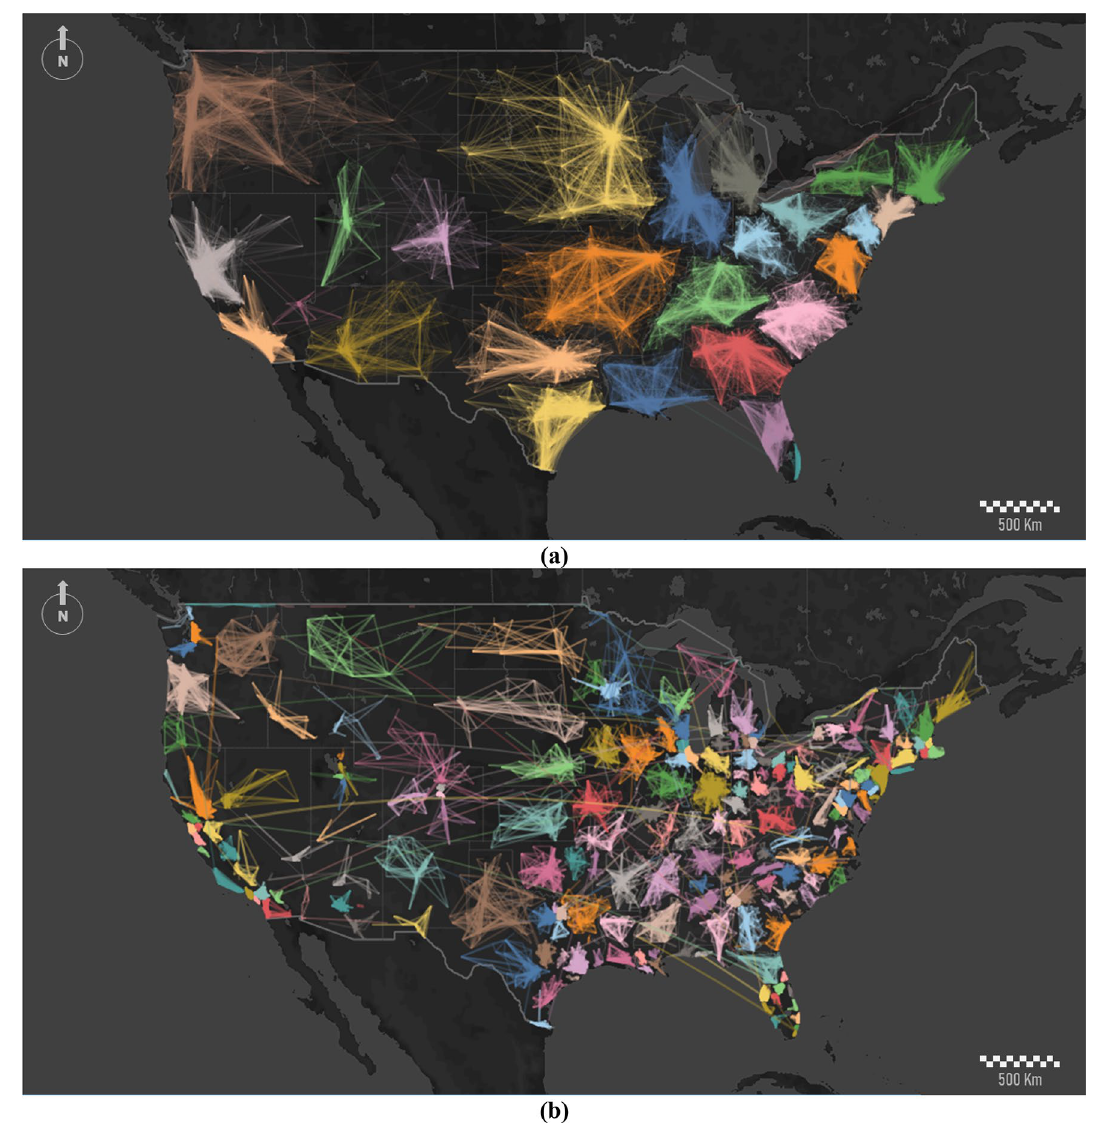
Figure 4. Node clustering and detection of communities/sub-communities from Twitter dataset in the United States mainland. We detect ( a ) 39 major communities and ( b ) over 216 sub-communities. Consistent partitions were obtained over 85% of realizations. To make the display clearer, we apply a thinning algorithm for reducing line densities. We reduce the total number of links by 40%. This figure was generated using ArcGIS Desktop and